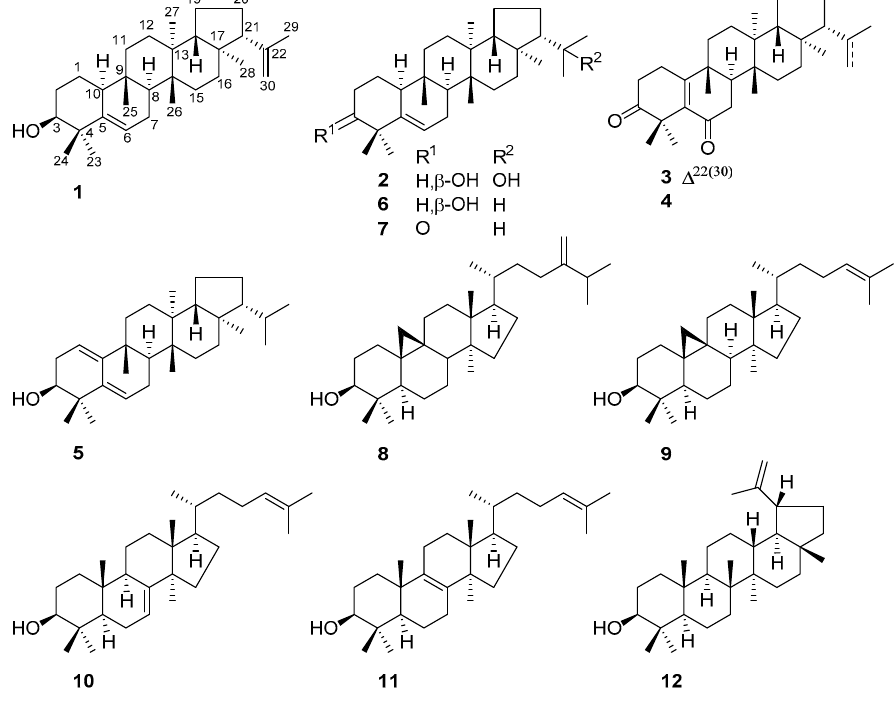
Figure 1. Structures of Compounds 1 – 12 .